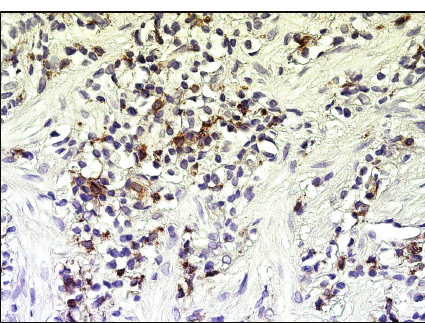
Figure 6: The numerical density (Nai) of lymphocytes and macrophages expressing